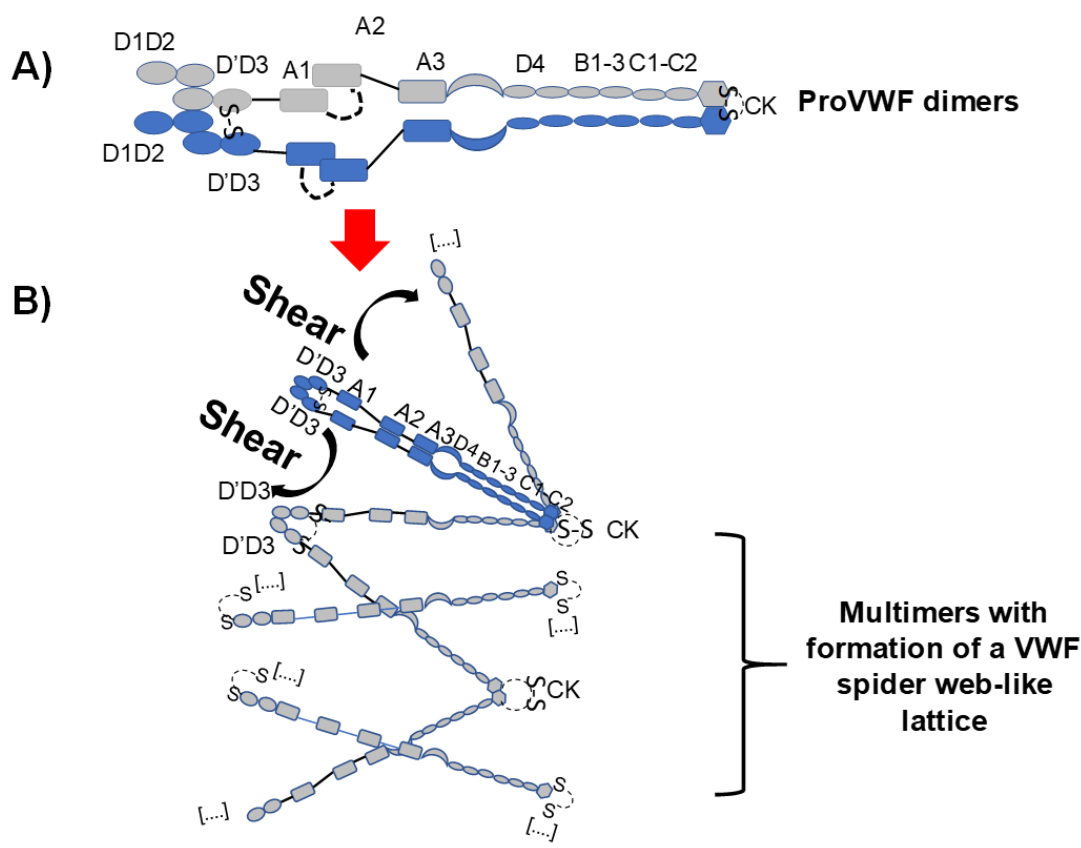
Figure 6: Schematic cartoon showing the assembly of proVWF dimers in helical tubules according to the data reported in [83, 88]. A) Assembly templates disulfide bond formation between D’D3 domains of adjacent proVWF dimers is favored by the non-covalent dimerization of the N-terminal ends of proVWF dimers through homotypic interactions between the D1 and D2 domains. Note the partial shielding of the A2 on the A1 domain in the dimer in the absence of shear forces. B) Under the effect of mechanical forces, the multimers are unfolded and stretched, with the A1 domain available to interact with the platelet receptor GpIb. At the same time, through the 3D swapping mechanism, the unfolded dimers can interact each other to form a spider web-like